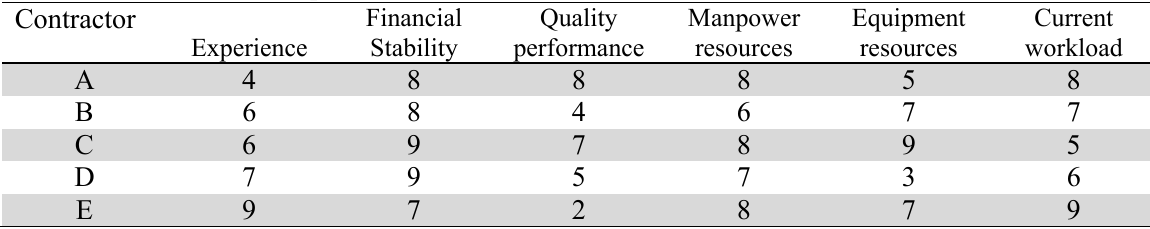
The data for the relative importance of different factors Contractor